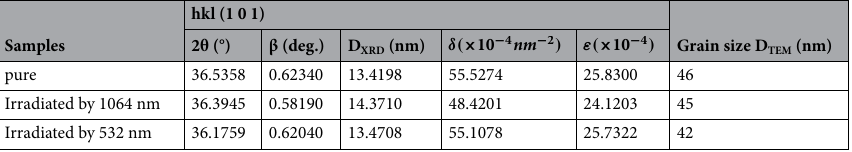
Table 1. ZnO crystallite size before and after irradiated with lasers having wavelengths of 532 nm and 1064 nm .